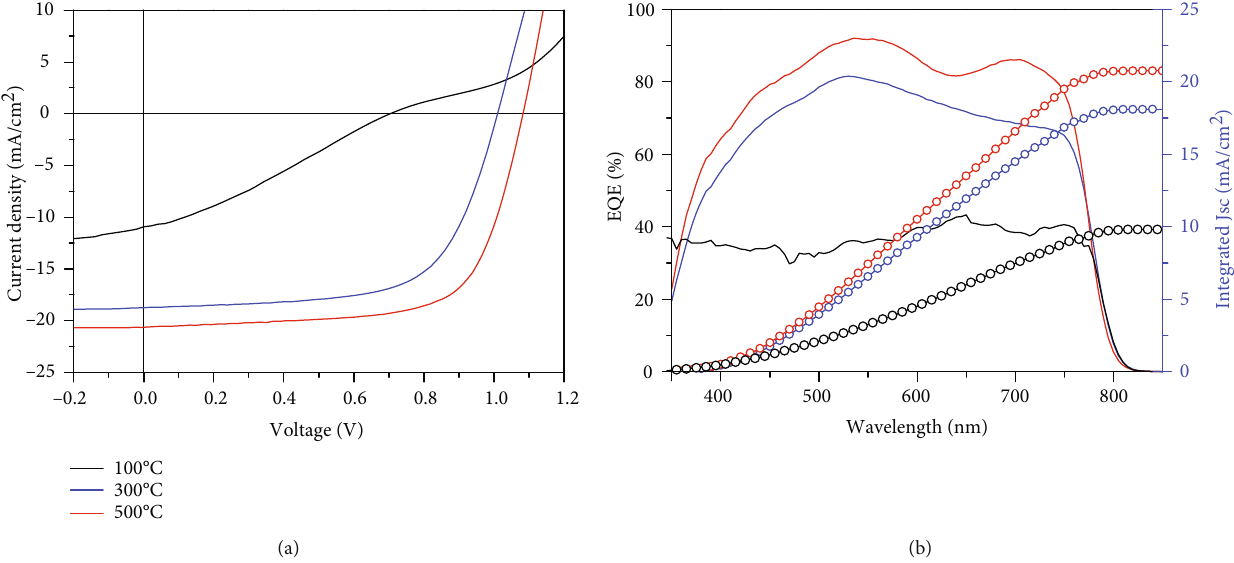
Figure 4: (a) The JV curves and (b) EQE pro fi les of perovskite solar cells based on NiOx annealed at 100 ° C, 300 ° C, and 500 °